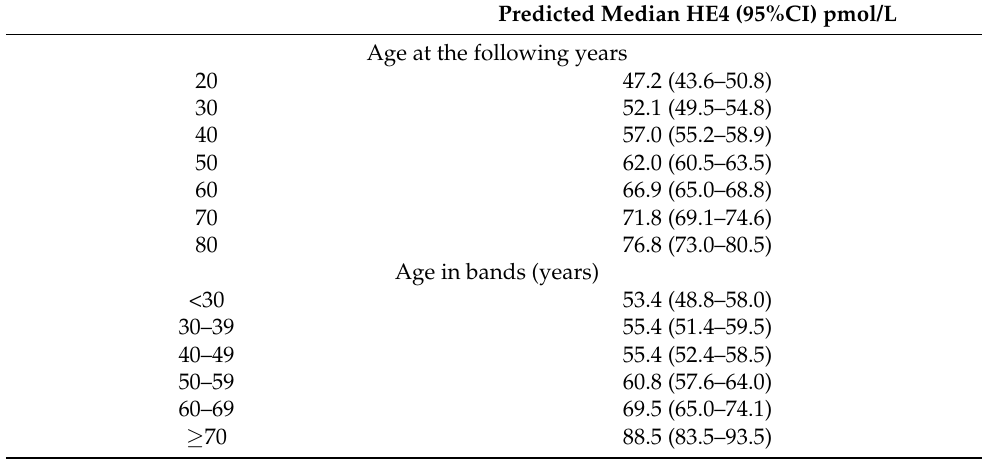
Table 5. Impact of age on serum HE4 using quantile regression.